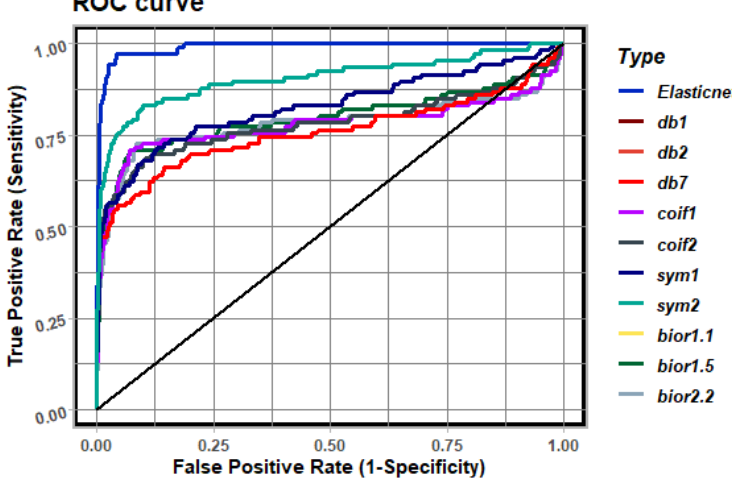
Figure 7. ROC analysis for example 1. Table 1. Summary of reconstruction of pattern presented in Figure 6.